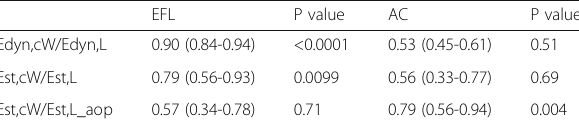
Table 1 (abstract 000048). Area under ROC curve (95% confidence intervals) for EcW/EL ratio for EFL and AC